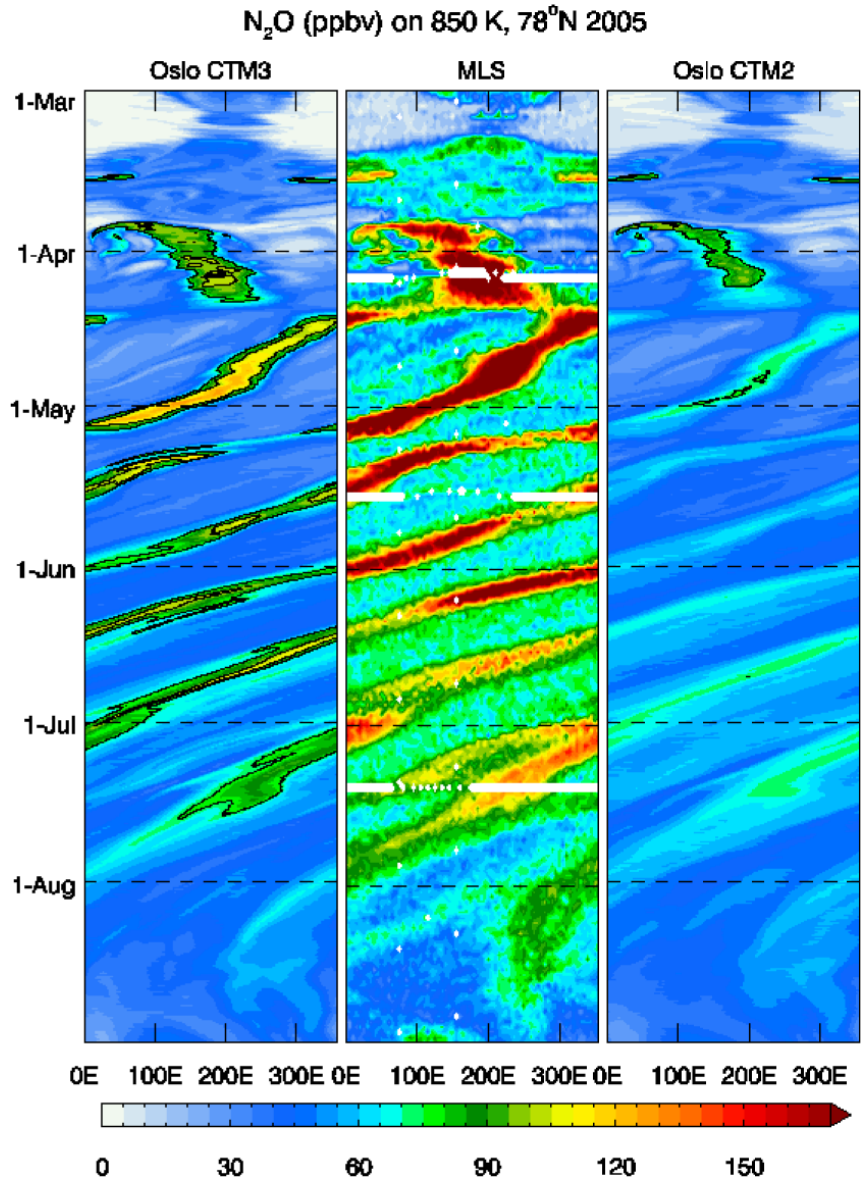
Fig. 8. Hovm¨oller plot of N 2 O at 850K and 78 ◦ N, as modelled by Oslo CTM3 (left), measured by MLS (middle) and modelled by Oslo CTM2 (right). Contours on CTM panels are 75ppb and